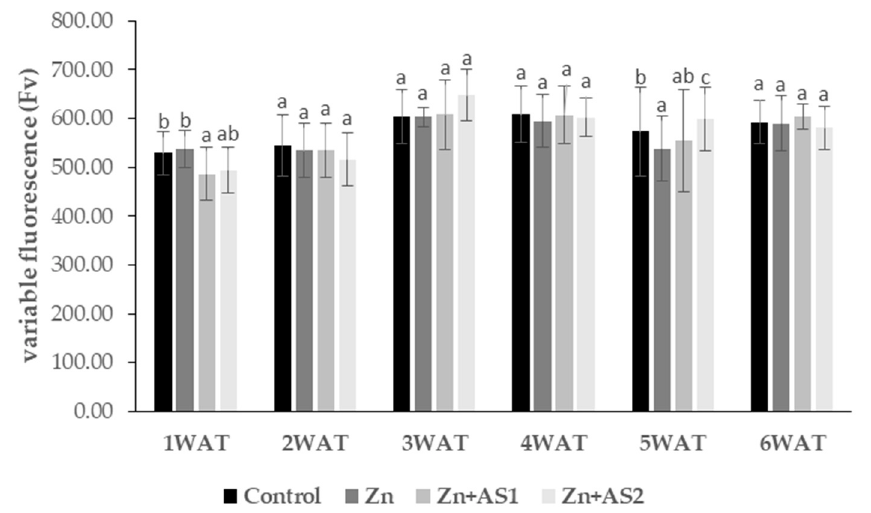
Figure 4. The effect of different foliar treatments (Zn, Zn+AS1, and Zn+AS2) on the variable fluorescence (F v ) in the second youngest and fully developed leaves of maize 1, 2, 3, 4, 5, and 6 WAT. n = 20 ± S.D. Lower case letters (a, b, and c) show the significant differences among the treatment based on sampling time. WAT: week(s) after treatment.